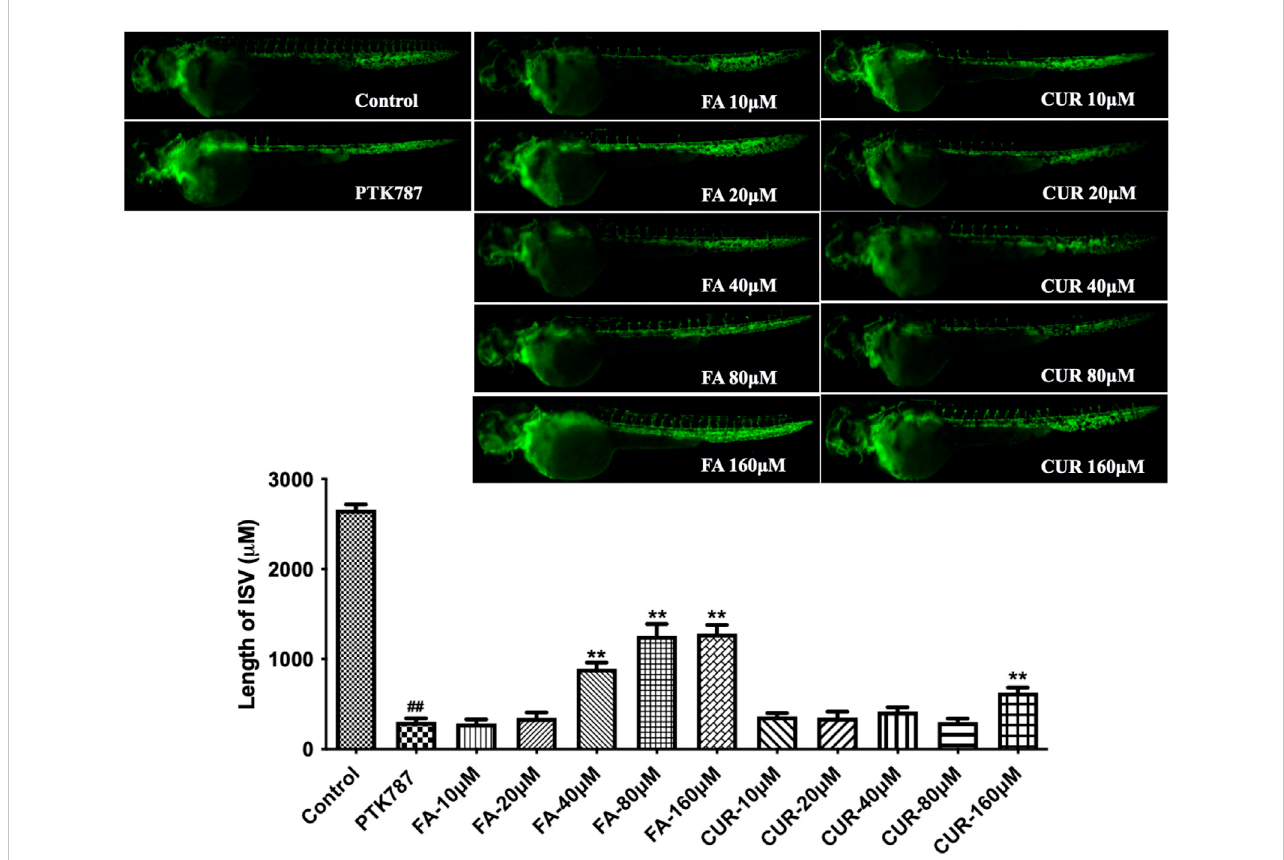
FIGURE 6 Ferulic acid (FA) and curculigostide (CUR) stimulated angiogenesis in a zebra fi sh model. Lateral view of zebra fi sh embryos treated with DMSO (0.1%, Control),PTK787(0.2 μ g/mL),PTK787plusFA(10,20,40,80,and160 μ M)orCUR(10,20,40,80,and160 μ M)for24 h.FA(at40,80,and160 μ M)andCUR(at 160 μ M) restored angiogenesis in ISVs against PTK787-induced impairment. Statistical analysis data were shown as mean ± SEM ( n ≥ 8). The comparison between groups was performed by student ’ s test. ## p < 0.01 versus Control group; ** p < 0.01 versus PTK787-treated